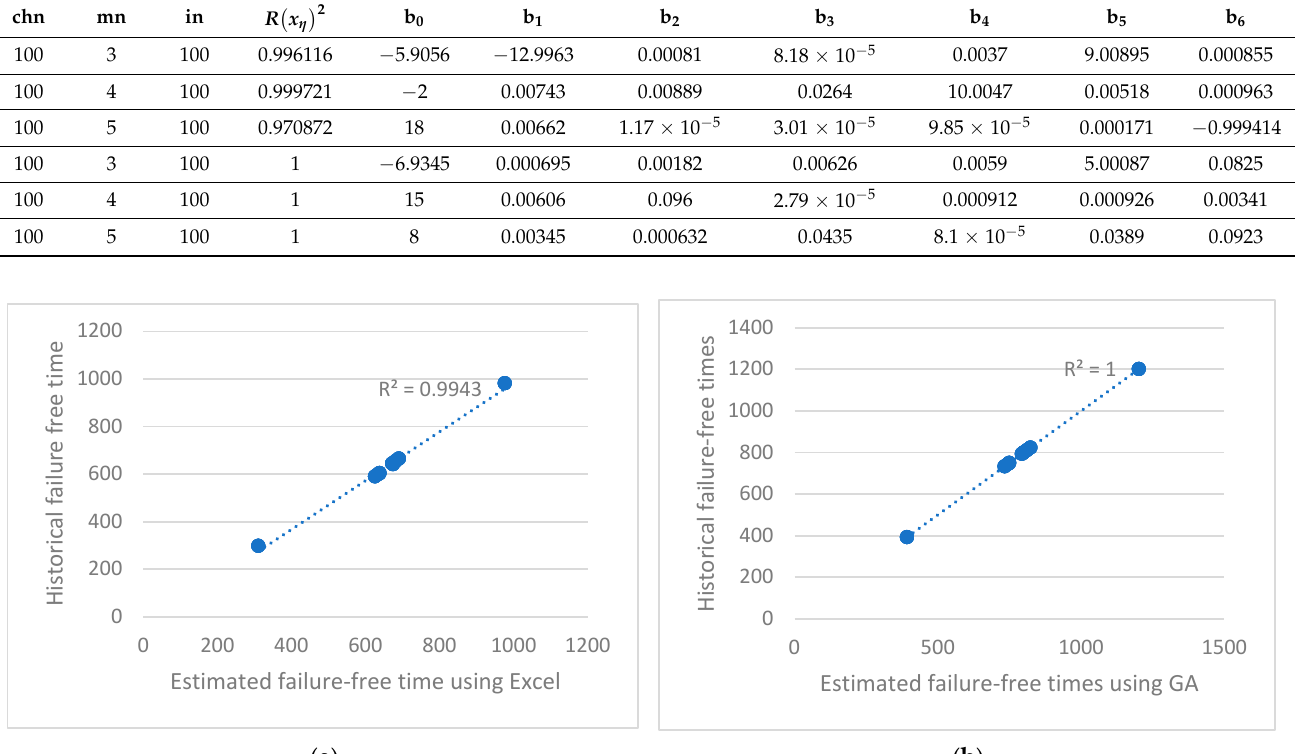
Figure 8. Variation of estimated failure-free time (minutes) depending on historical failure-free times achieved using ( a ) Excel (17) and ( b ) GA (23).